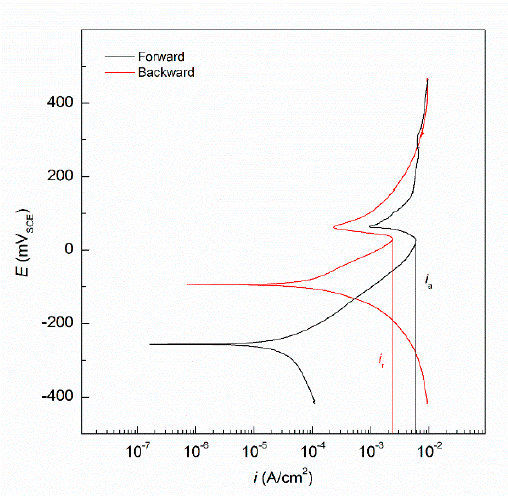
Figure 5. DL − EPR plot of UNSM treated Inconel 718 annealed at 1000 ◦ C for 10 min and water quenched, repeated three times each, Sample I4. Table 4. Degree of sensitization values for the di ff erent thermo-mechanically treated samples of Inconel 718, DOS = ( i r i a × 100 ) .